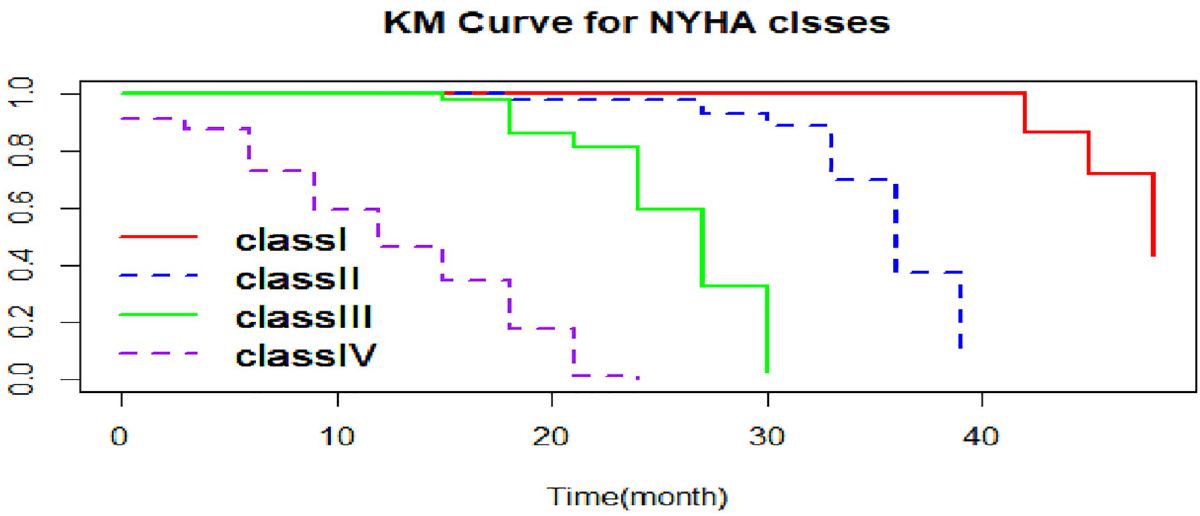
Fig 3. The K-M survival function for complication time of CHF patients by NYHA classes.